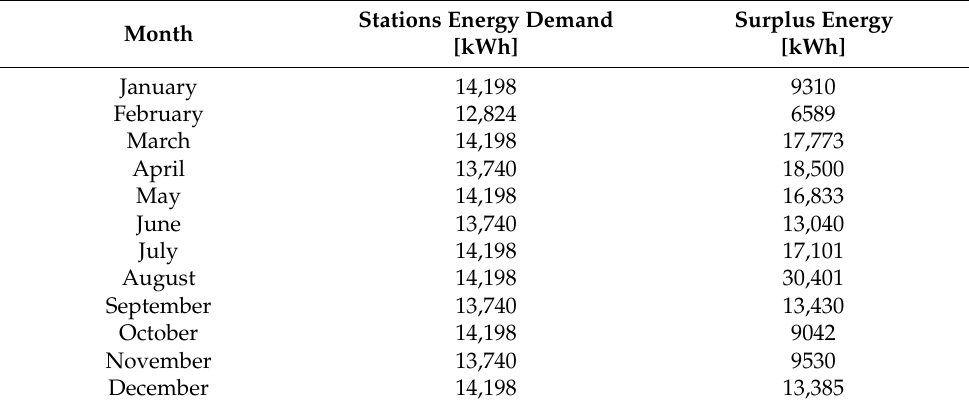
Table 7. Aggregated monthly energy consumption of the refurbished stations and surplus ene- rgy